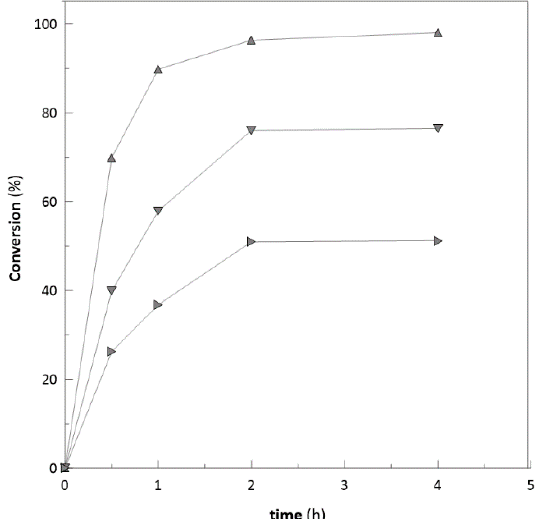
Figure 2. Achieved substrate conversion with different initial substrate concentrations (4-phenyl-2-butanone: ▲ 20 mM; ▼ 50 mM ; ► 100 mM).